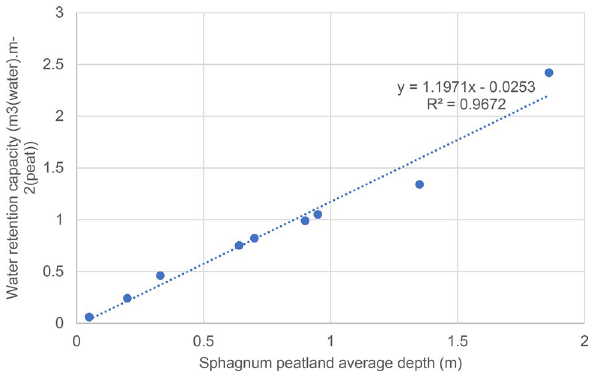
Fig. 7 Relation between Sphagnum peatland depth and water retention capacity. Peat depth obtained by GPR and modulated in GIS. Water retention capacity values obtained in the lab as described by Pereira (2015) [16]